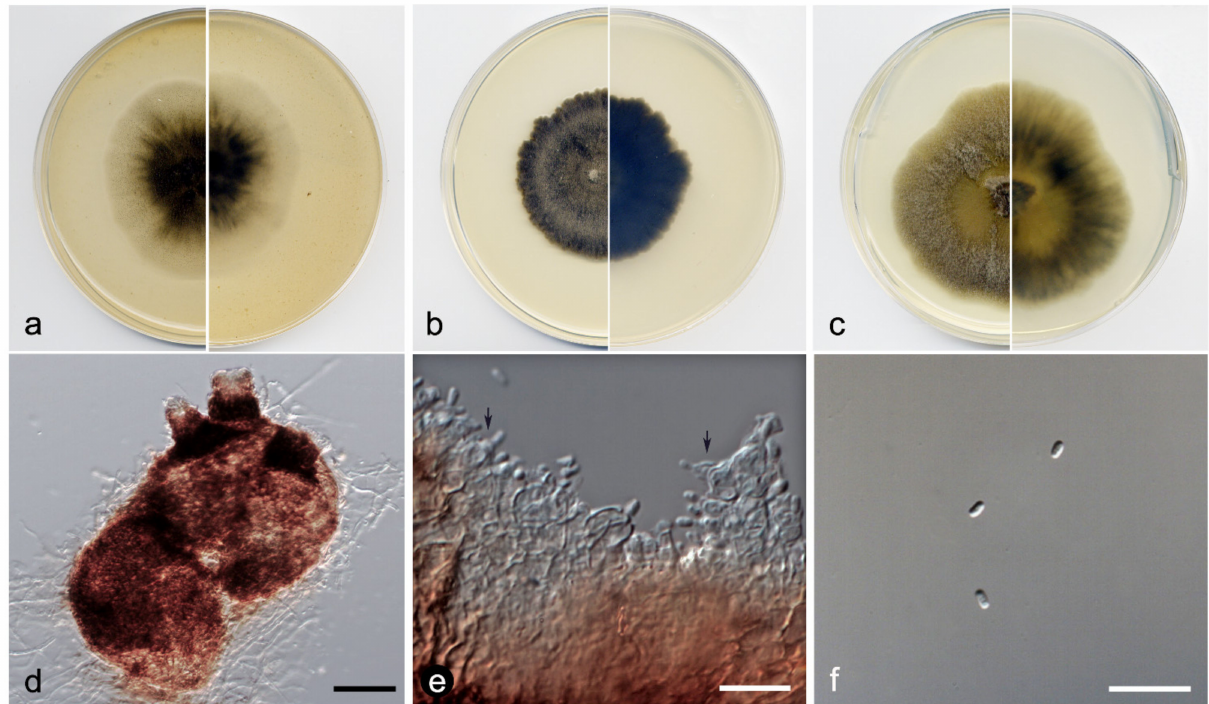
Figure 8. Xenophoma microspora FMR 17947: ( a ) colonies on OA; ( b ) MEA; and ( c ) PDA after two weeks at 25 ± 1 ◦ C (surface, left; reverse, right); ( d ) pycnidium; ( e ) conidiogenous cells (black arrows); ( f ) conidia. Scale bars: ( d ) = 50 µ m, ( e , f ) = 10 µ